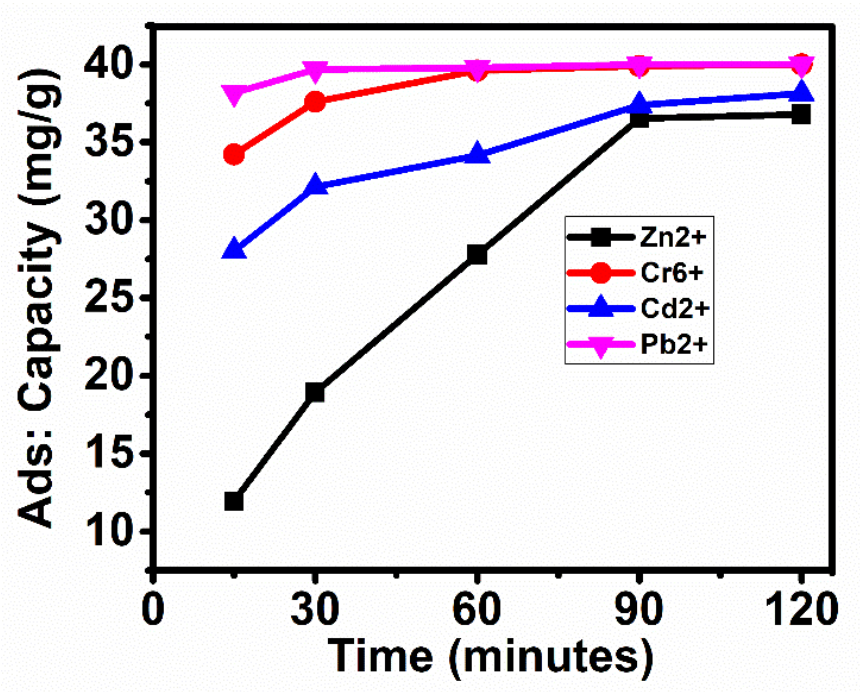
Figure 7. Adsorption capacities (q e ) of FAC at different time intervals for the adsorption of metal ions; Zn 2+ , Cr 6+ , Pb 2+ and Cd 2+ .